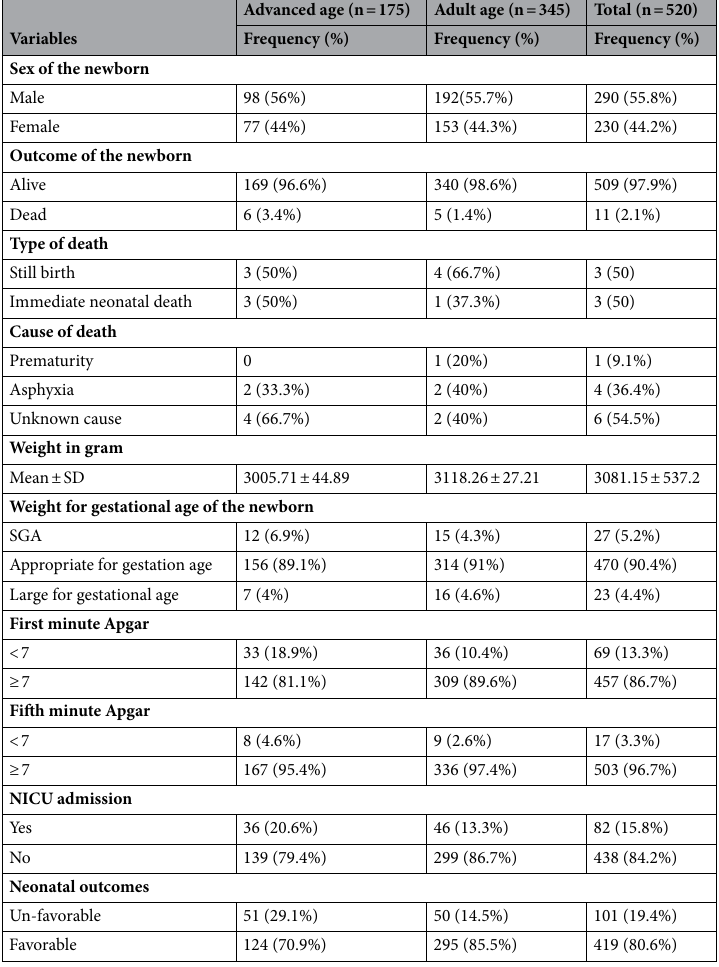
Table 4. Perinatal characteristics of mothers who gave birth in Awi Zone Public Hospitals, Ethiopia, 2020.